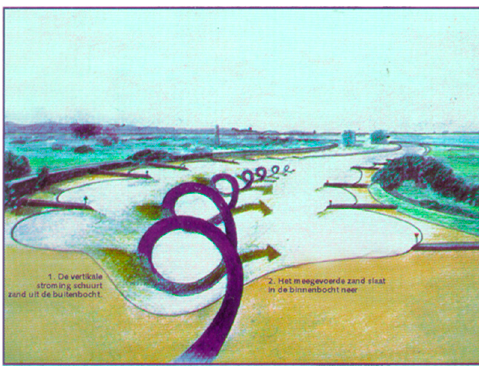
Figure 12. Artist impression of spiral flow in a bend (copyright Kees Nuijten).